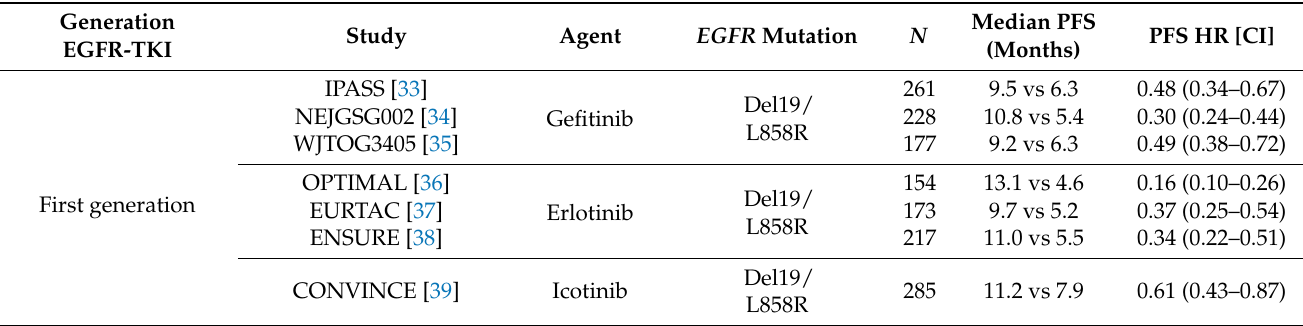
Table 1. Studies of targeted therapies in first-line therapy for advanced NSCLC with EGFR mutation. Generation